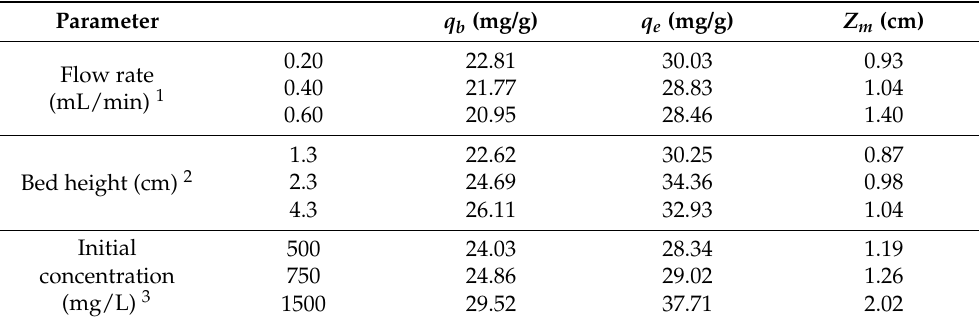
Table 1. Length of mass transfer zone, adsorption capacity of Pb(II) at breakthrough, and adsorption capacity of Pb(II) at exhaustion under various operating